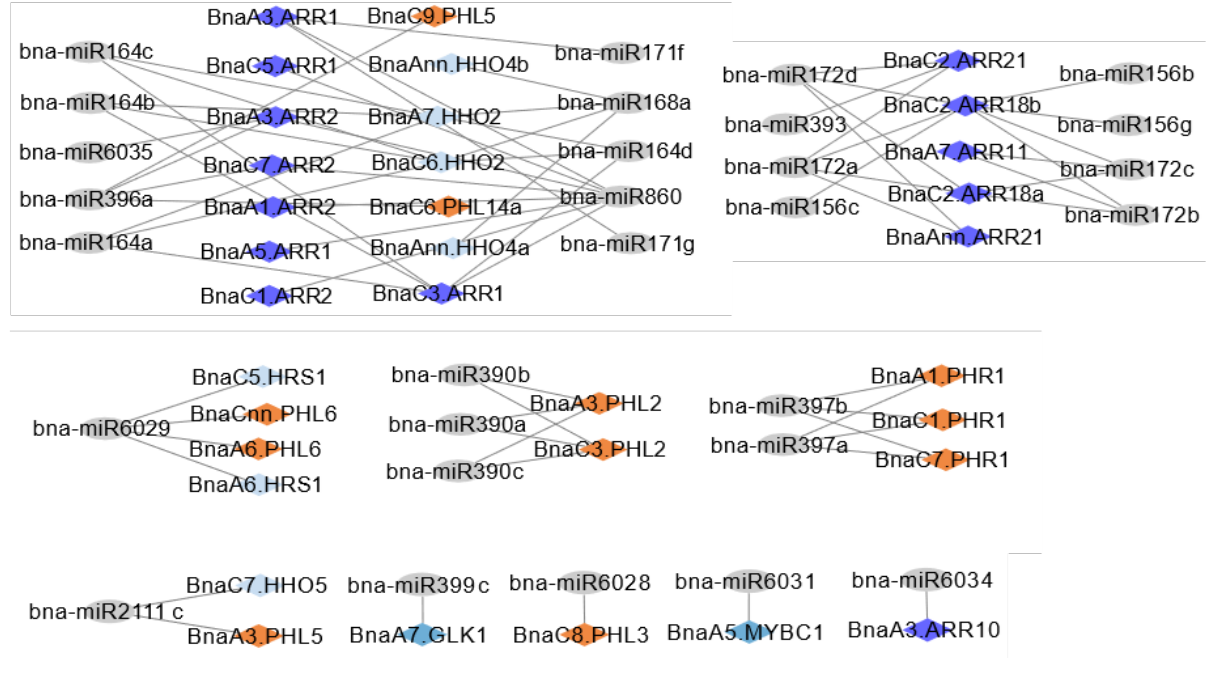
Figure 7. Network diagrams of predicted miRNAs targeting BnaGARPs . Different diamond colors represent BnaGARPs , and gray ellipse shapes represent potential regulatory miRNAs.